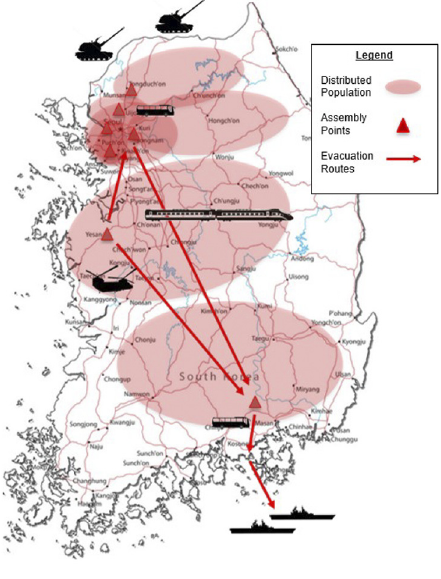
Figure 2. The South Korea NEO mission starkly contrasts with the typical NEO scenario described in Figure